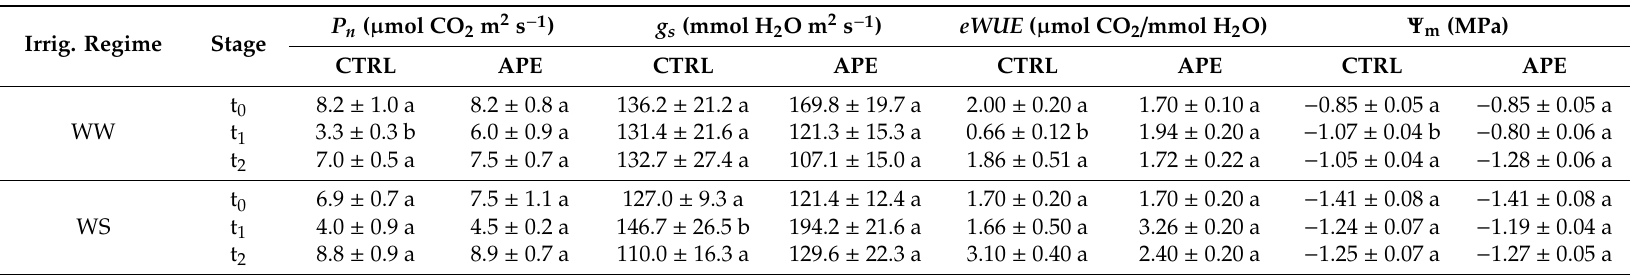
Table 1. Physiological parameters. Net photosynthesis ( P n ), stomatal conductance ( g s ), water use e ffi ciency ( eWUE ), and midday stem water potential ( Ψ m ) of Vitis vinifera treated with Arthrospira platensis F&M-C256 extract (APE) and control plants (CTRL), under two water regimes (well-watered, WW; water-stressed, WS). Assessments were attended at t 0 , t 1 , and t 2 . One-way ANOVA was performed on data (mean ± SE, n = 10). Within the same row and parameter, di ff erent letters mean significant di ff erences among APE and CTRL (LSD test, p ≤